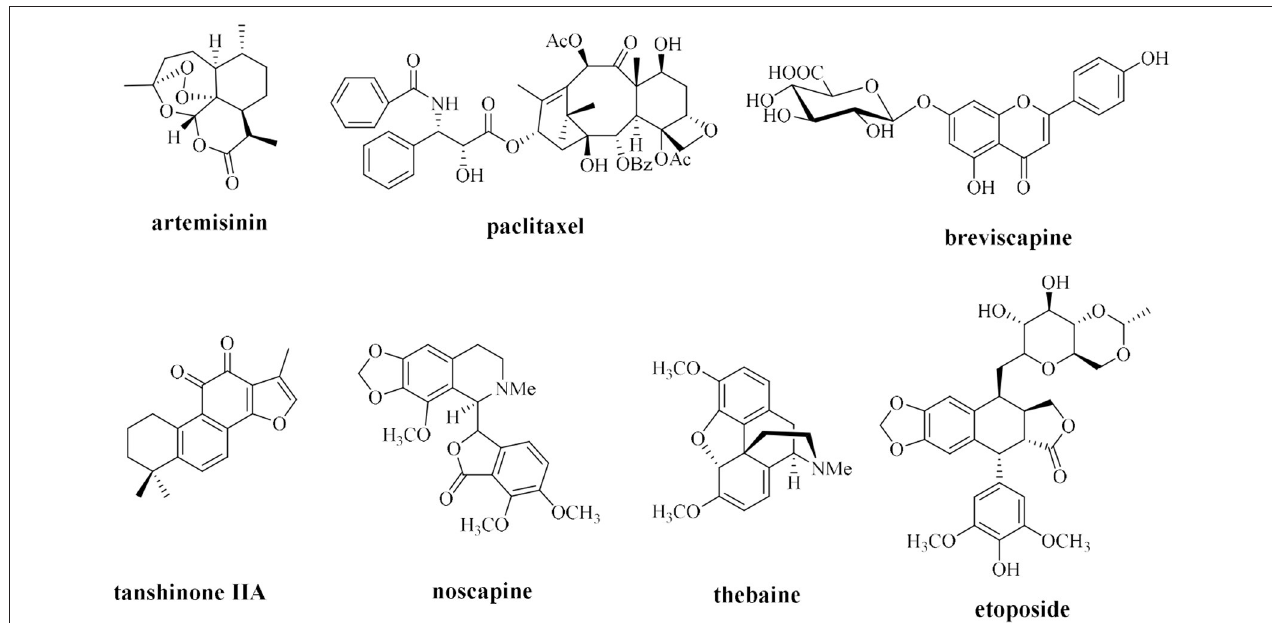
FIGURE 1 | Some natural drugs studied by synthetic